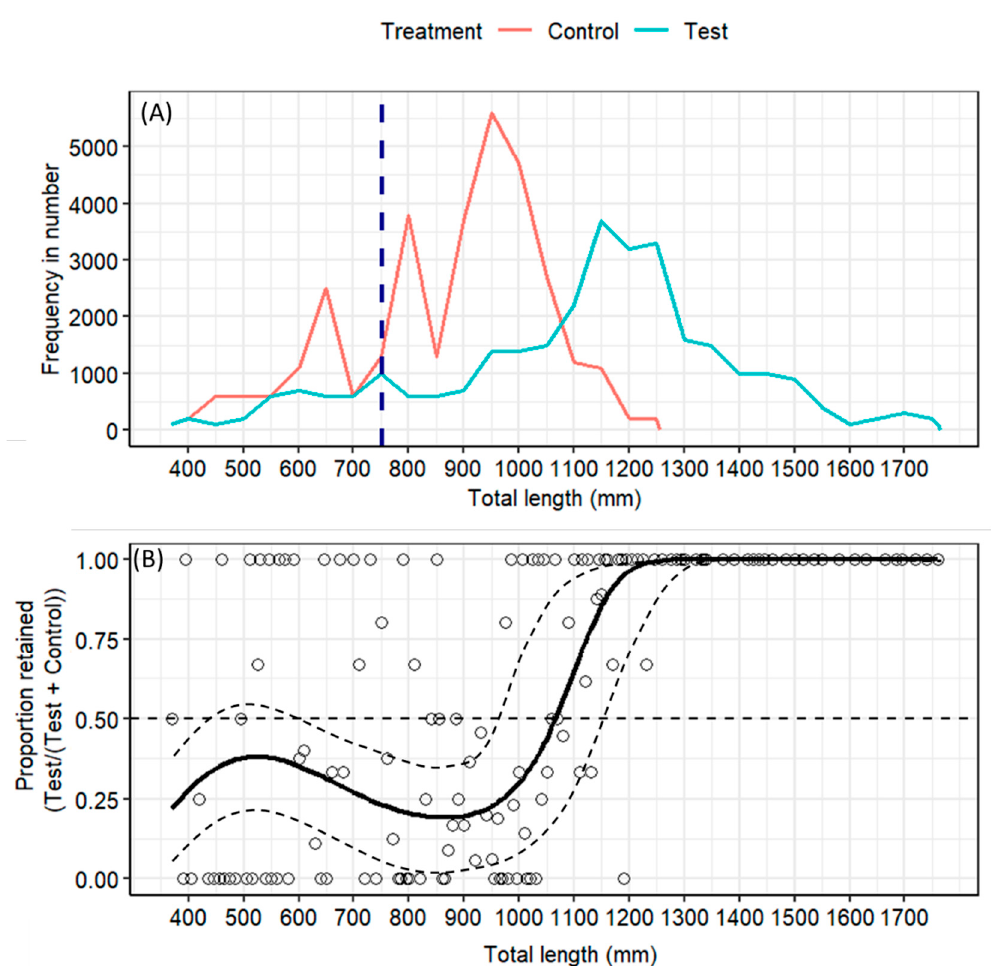
Figure 6. Length frequency curves for narrow-barred Spanish mackerel captured by the control and experimental gillnets ( A ). GLMM results for the proportion of the total catch retained by control gillnets compared with experimental gillnets ( B ). The vertical blue dashed line in the top panel indicates the maturity size of narrow-barred Spanish mackerel at 752 mm total length. The horizontal dashed line at 0.5 in the bo tt om panel indicates equal performance of both experimental gears. A value of 0.25 indicates the given length class where 25% of fi sh were captured by the experimental gillnets and 75% of fi sh were captured by control gillnets. Contrastingly, a value of 0.75 means that 75% of fi sh were caught by the experimental and 25% by the control gillnets. The solid black curve in the bo tt om panel models the mean total length at given size, while the gray shaded areas are the 95% con fi dence intervals. If con fi dence intervals overlap at 0.5, then there is no statistically signi fi cant di ff erence in catch-at-length between control and experimental gillnets at the given length class. Table 2. GLMM results for the control vs. experimental gillnet comparison. Bold p-values denote the selected model with the lowest AIC and the model parameters resulted in being statistically signi fi cant. SE is the standard error of the estimate.